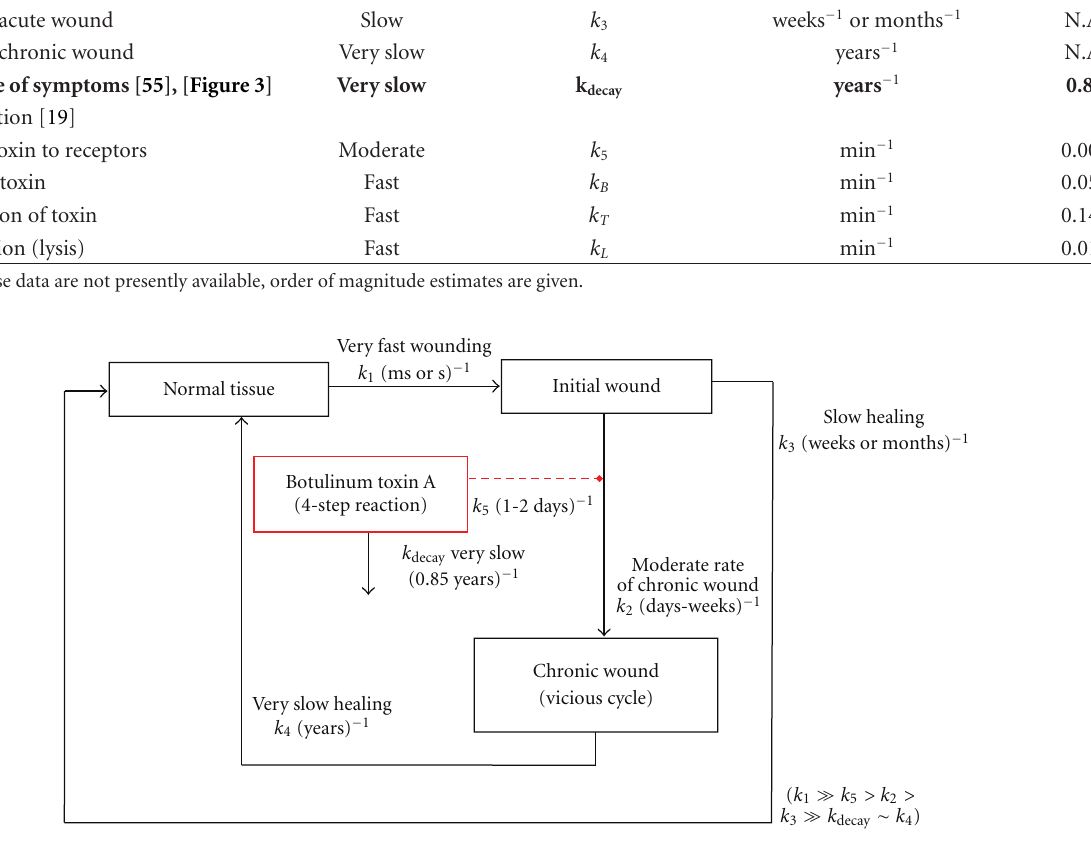
Figure 4: A minimal kinetic model for enhanced wound healing with botulinum toxin. Wounding of the normal tissue state is assumed to occur most rapidly leading to an initial wound state of the tissue. Healing from a significant wound is typically a slow process taking weeks or months. In the meantime, without treatment, this system enters, at a moderate rate, into a vicious cycle state (Figure 2) from which its escape represents a very slow healing process. With botulinum toxin treatment, this cycle is blocked thus allowing the tissue to return to the normal state by the slow healing route. The four-step reaction of toxin binding, translocation, internalization, and toxicity is described elsewhere [19]. A competing reaction is depicted as the slow decay or the inactivation rate of this toxin ( k decay ) that leads to a recurrence of